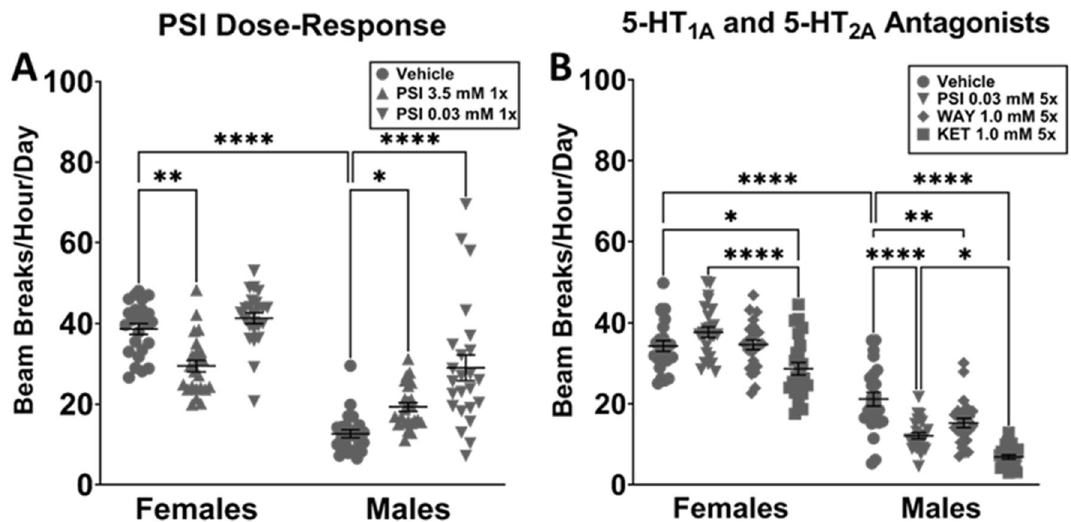
Figure 4. Use of METH, αMT, and CIT to establish predictive validity of FST. The changes in metrics of immobility in the forced swim caused by dopaminergic modulators METH (5.0 mM) 5× and αMT (3.0